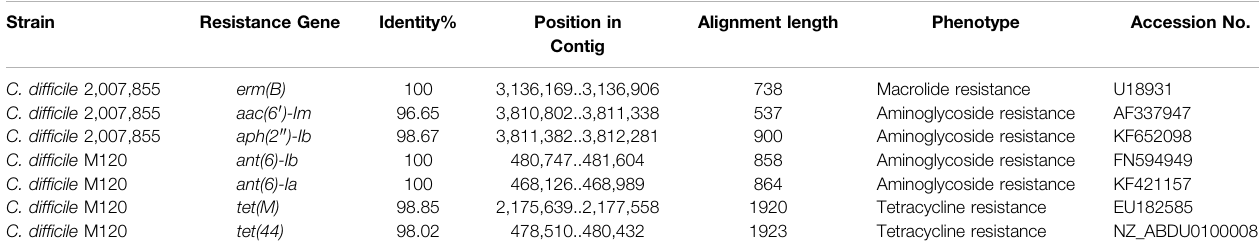
TABLE 3 | AMR genes determination in WGS strains of C. dif fi cile 2,007,855 and M120 using ResFinder